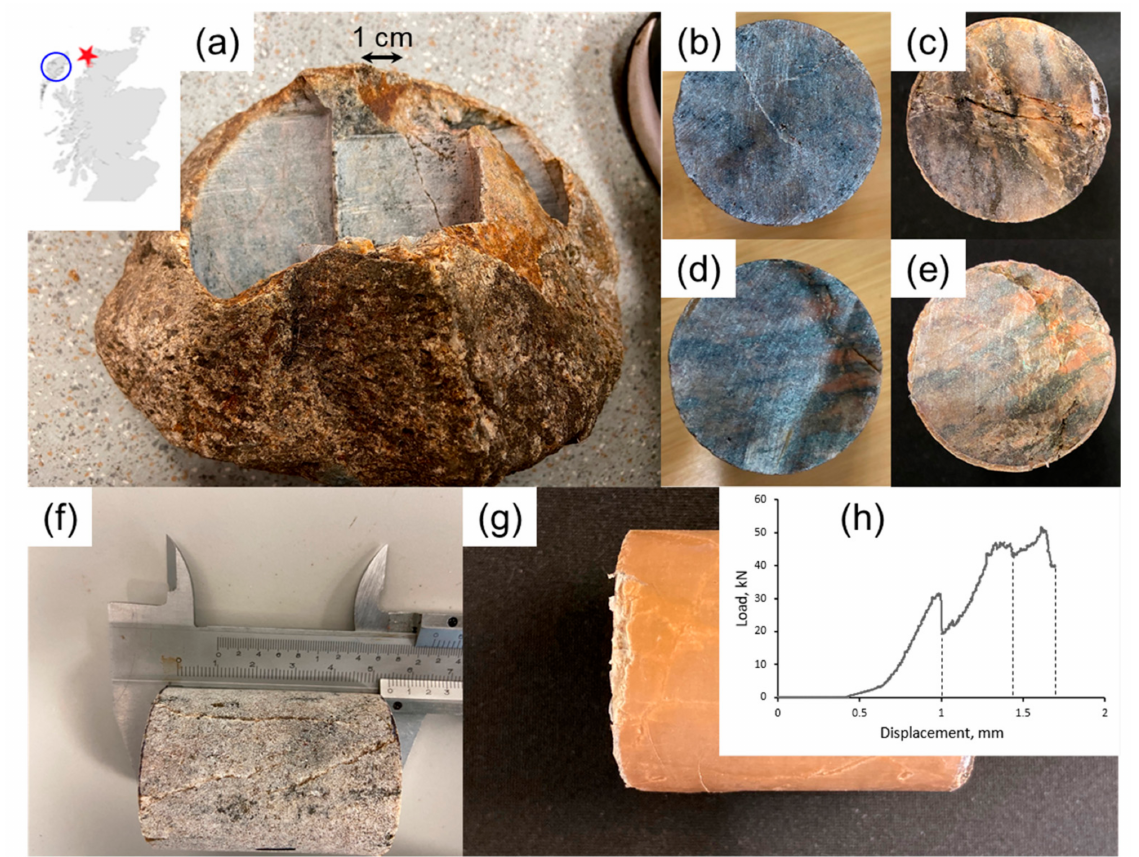
Figure 1. Rock sample used in this study was cut from the weathered outcrop boulder ( a ) collected from the Clashnessie area denoted by the red star on the inset map (refer to the geological map of the area, S1, in the supplementary material); the core sample was naturally fractured as demonstrated by the top ( b ), bottom ( d ) and side ( f ) views; the sample was loaded along the longitudinal axis resulting in at least one fracture that extended from the top face ( c ) to the bottom one ( e ); to preserve its cylindrical shape during uniaxial loading, the sample was wrapped in duct tape ( g ) and experienced fracturing that corresponded to bulk displacements of 1 mm, 1.4 mm and 1.7 mm, as demonstrated by the load [kN] vs. displacement [mm] graph ( h